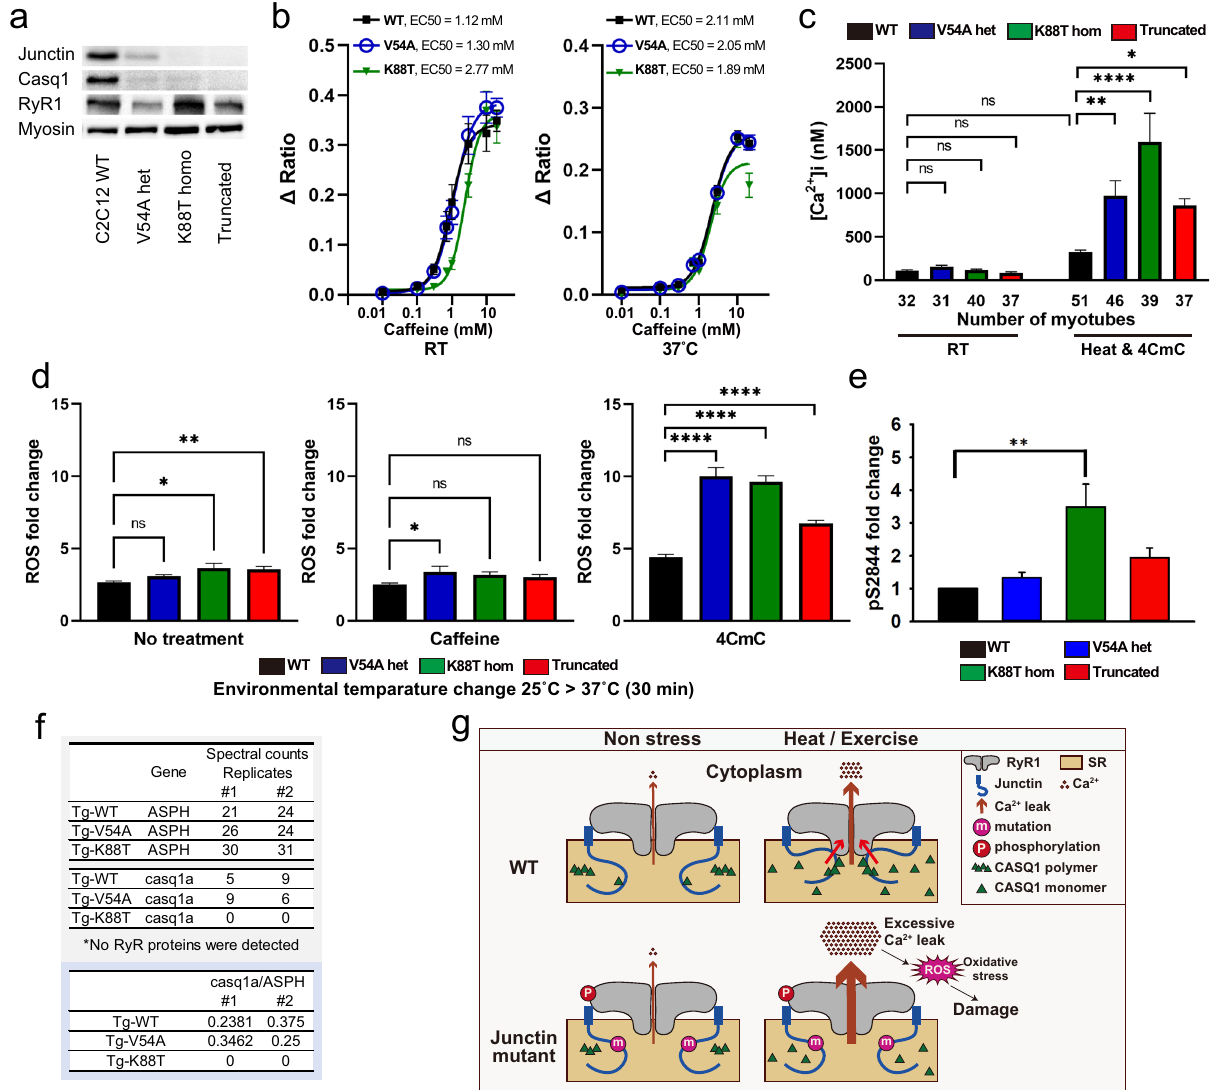
Fig. 4 Analysis of junctin variant knock-in C2C12 myotubes. a Junctin expression in C2C12 myotubes was assessed by western blotting. Myosin heavy chain was used as a loading control and a differentiation marker and was probed on the same blot as junctin. Blots for Casq1 and RyR1 were processed in parallel using the samples derived from the same experiment. Total protein was also used as loading controls (Source data fi le). b Concentration dependence of caffeine-induced SR calcium release in C2C12 myotubes. Left panel; at room temperature, 4 replicates in each cell line. Right panel; at 37 °C, 8 replicates in WT and V54A, 9 replicates in K88T. c Resting intracellular calcium concentrations in C2C12 myotubes. Cytosolic calcium concentration was measured at RT or after heat and 50 μ M 4CmC exposure. The numbers of myotubes analyzed are shown below each bar. Statistical analysis was by one- way ANOVA followed by Dunnett ’ s multiple comparisons test. d DCFDA assay in C2C12 shows increased temperature-dependent ROS production in junctin mutant cell lines during 50 μ M 4CmC exposure. ROS was measured from 6-day differentiated myotubes after changes in environmental temperature (25 °C for 1 h followed by 37 °C for 30 min) with either no treatment (left panel), 1 mM caffeine (middle panel), or 50 μ M 4CmC (right panel). Statistical analysis of three independent replicates was done using one-way ANOVA followed by Dunnett ’ s multiple comparisons test. e A quanti fi cation of RyR1 phosphorylation (relative to WT) as measured by mass spectrometry and con fi rmed by Western blot analyses. Increased S2844 phosphorylation was seen in K88T cells as compared to controls. f Spectral counts of junctin and Casq1 proteins analyzed by AP-MS from junctin transgenic zebra fi sh ( n = 2 biological replicates). All data in ( b – e ) are represented as mean ± SEM. Differences were considered to be statistically signi fi cant at P < 0.05 (*), P < 0.01 (**), P < 0.001 (***) or P < 0.0001(****). Source data are provided as a Source data fi le. g Schematic summarizing the results of the study and the predicted impact of junctin variants on CASQ1, RyR1, and stress-related calcium